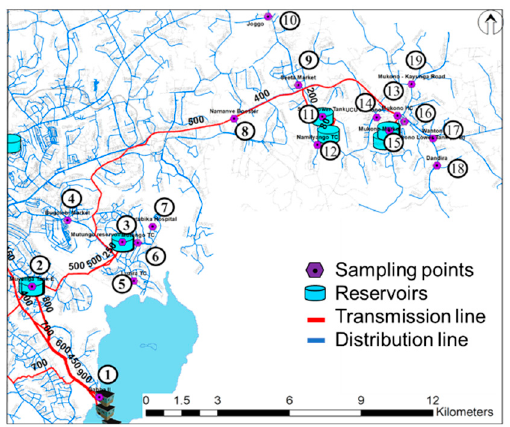
Figure 1. Kampala water distribution systems and pipelines from Ggaba II to Mukono town. The names of the numbered sites are shown in Table 1. Table 1. The number and name of each sampling location as well as their respective elevation in the Kampala water distribution system (elevation data was acquired from the National Water and